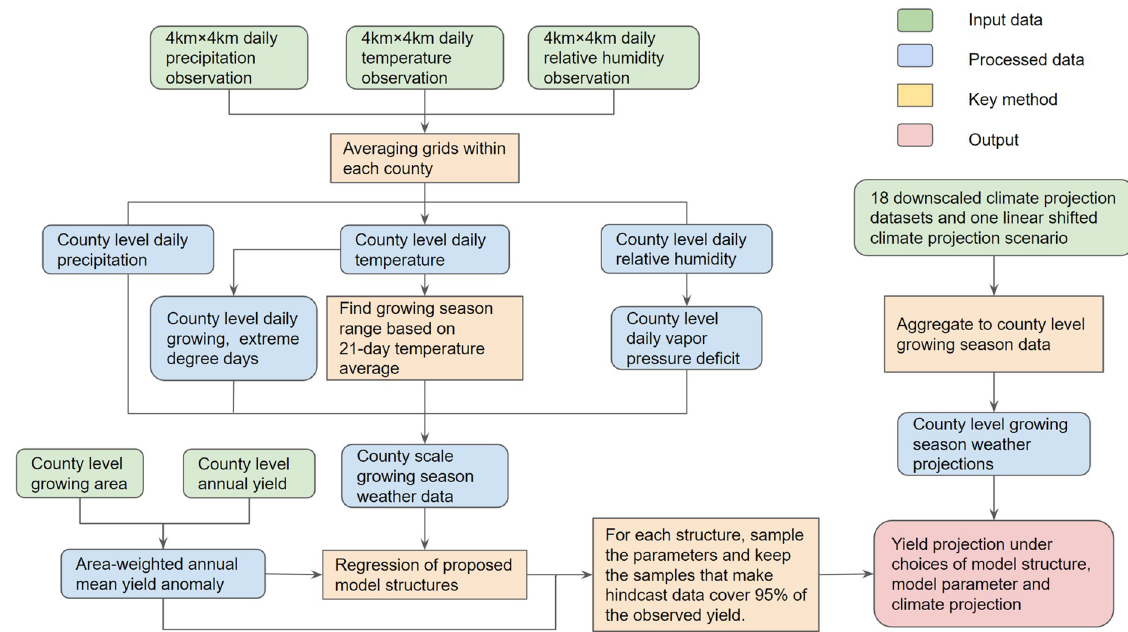
Fig 1. Analysis flow diagram. We adopt county level weather data and yield data to model the weather impact on maize yields. We consider parameter uncertainty through a pre-calibration method and climate forcing uncertainty through an ensemble of downscaled climate